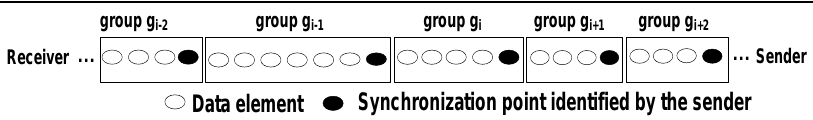
Figure 7. Group formation in SGW watermarking technique.